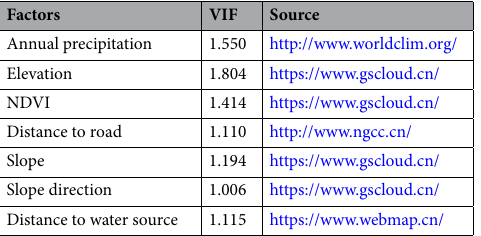
Table 1. Variance inflation factor value and data sources of selected